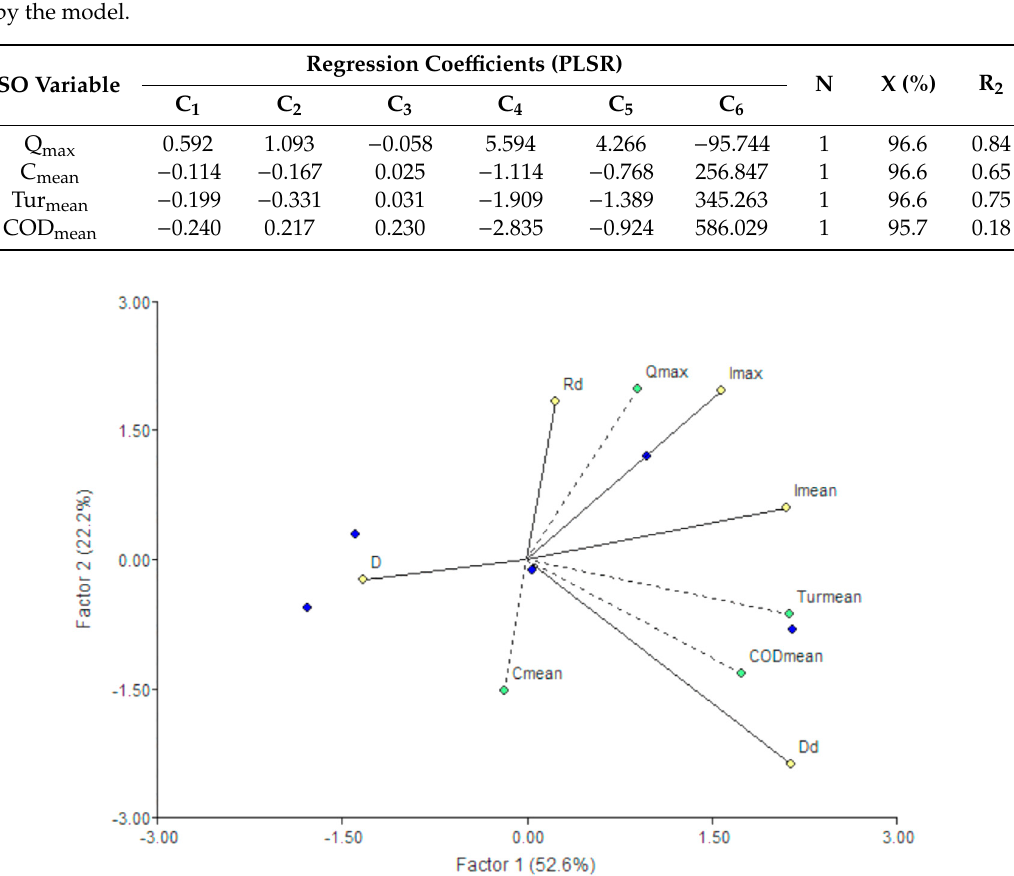
Figure A9. Triplot that represents the cases, the response variables and the predictor variables of the PLS model of the Coliseo CSO in the same graph.